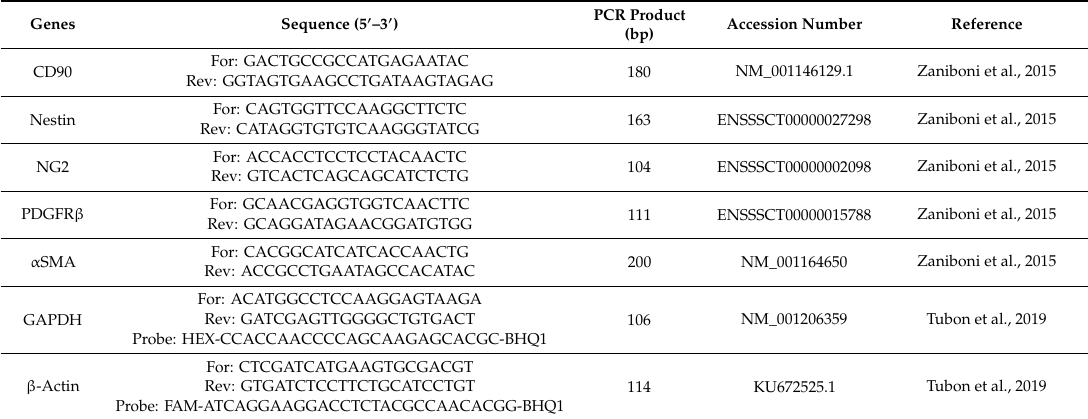
Table 1. Primer Sequences Used for the qPCR